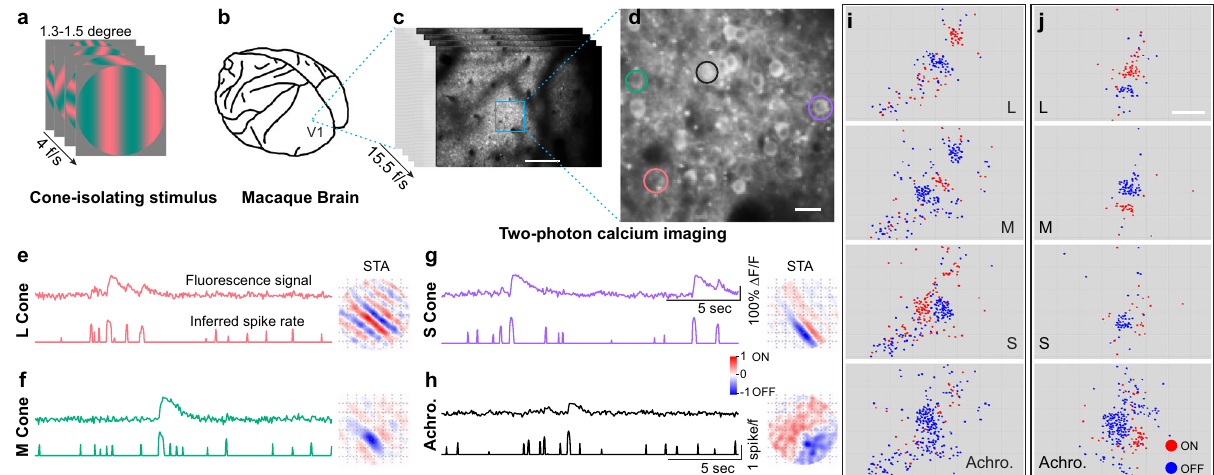
Achro. isolating( g ),orachromatic( h ) fl ashedsine-wavegratings,areshownasfourpanels. The fl uorescencesignal(uppertraceineachpanel)isnormalizedtotheresponseto blank condition ( Δ F/F ). The spike rate (lower trace in each panel) is inferred from raw fl uorescence signal. Red colors in the STA images indicate ON subregions of spatial receptive fi elds, and blue indicates OFF subregions. Each grid in the STA images is0.2°, and totalsize is 1.6°. i , j Functionalmaps of thelocationsof neurons with ON-dominant (red dots) and OFF-dominant (blue dots) receptive fi elds in response to each stimulus type (L-, M-, and S-cone isolating and achromatic (Achro.)). Neurons are organized in ON and OFF clusters. i , j are two imaging regionsfromanimalA1(moreexamplesareshowninSupplementaryFig.1andalso summarized in Supplementary Table 1); both panels illustrate results from two merged imaging planes. Scale bar in j : 200 µ m; applies to all panels in i and j